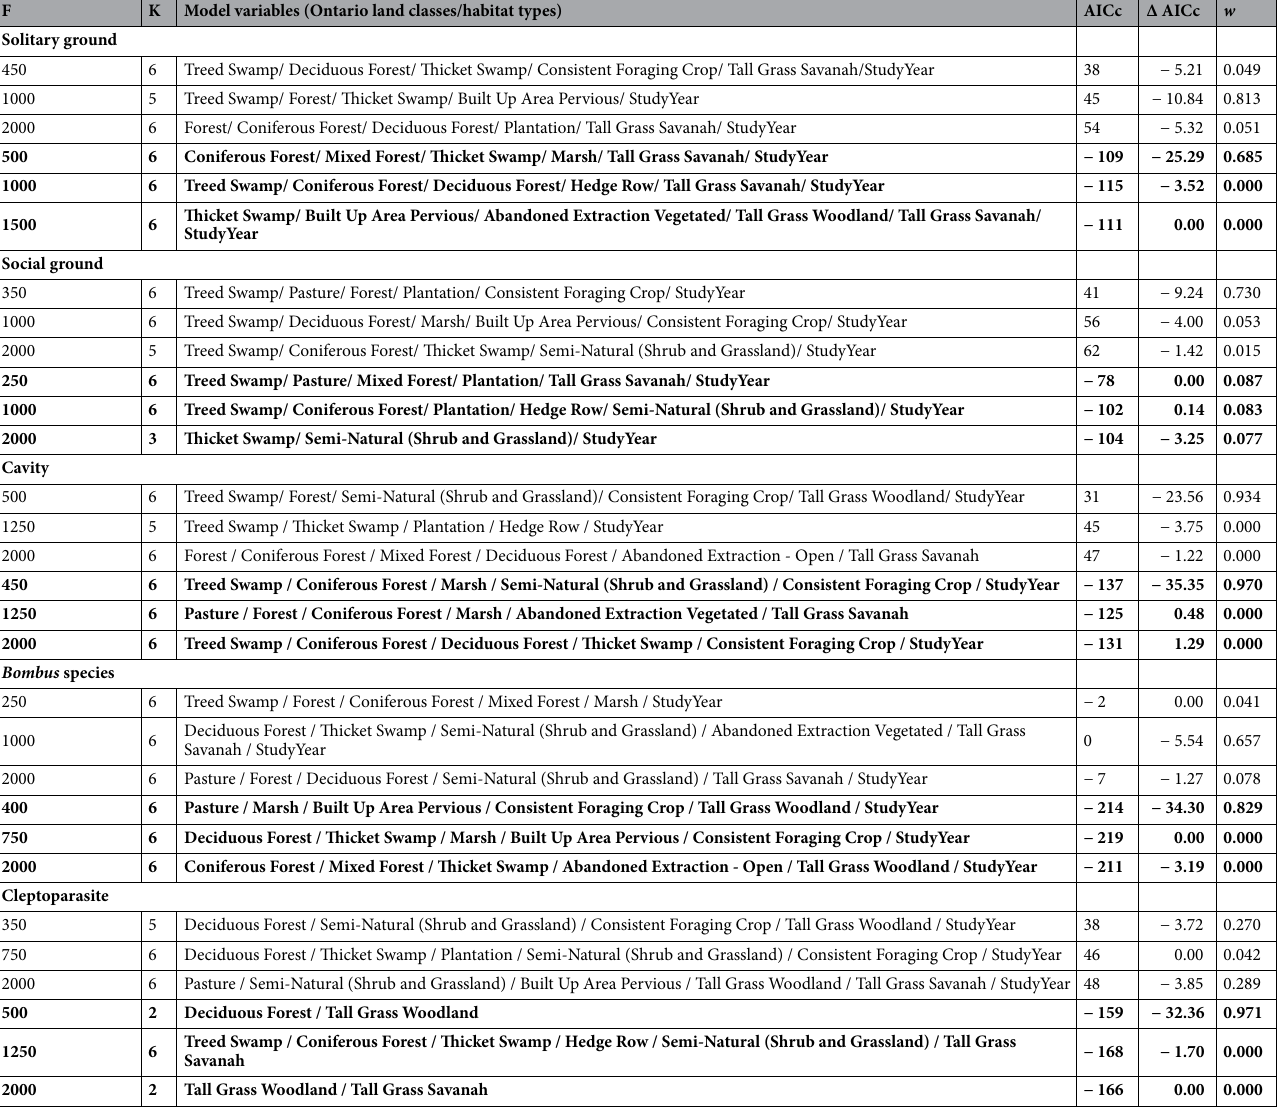
Table 2. The three top models testing relationships between bee functional guild (solitary ground nesters, social ground nesters, cavity nesters, bumblebees ( Bombus spp.) and cleptoparasites) metrics (species richness and proportional abundance) and pollinator habitats (model explanatory variables). F is the spatial scale (m) from each site within the landscape; K is the number of parameters included in each candidate model; model parameters are habitat types and study year, AIC is Akaike’s Information Criterion, and w is Akaike weight. Bolded Rows represent functional guild abundance while non-bolded rows represent species richness.